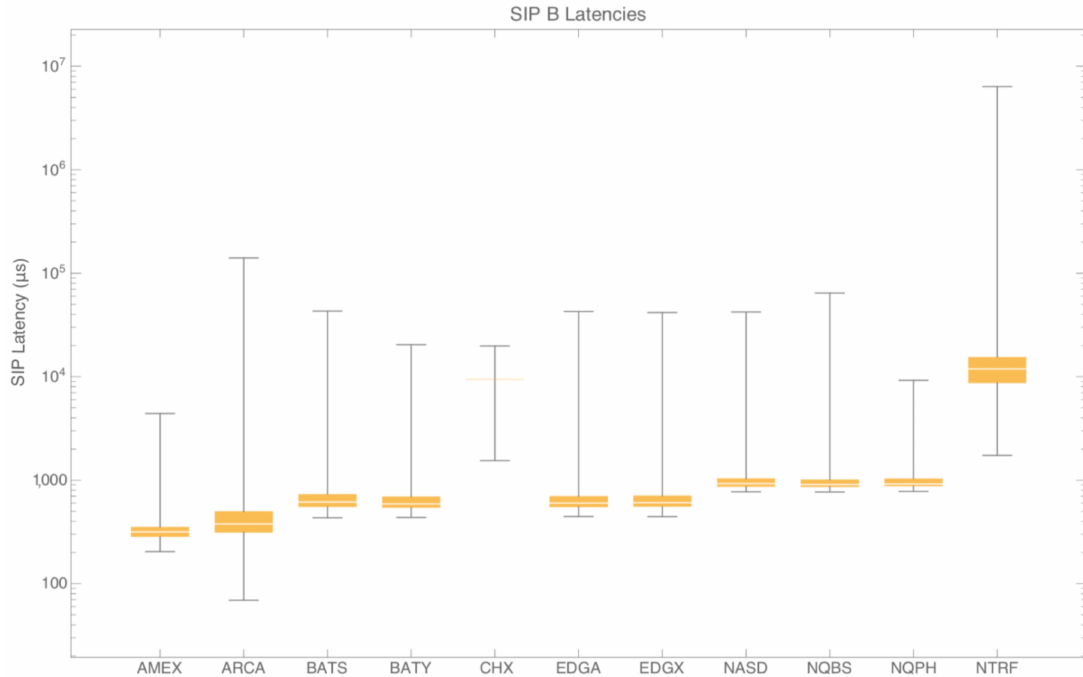
Figure 11. Box plots of latencies for all trades of all stocks traded on 11 August 2015 in microseconds reported by SIP B and separated by